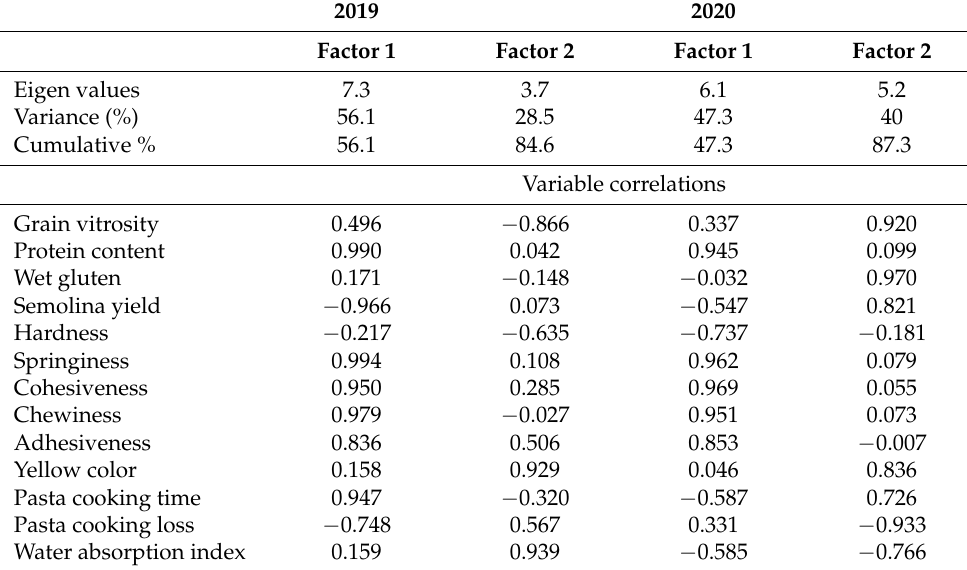
Table 5. Biplot of principal component analysis based on the correlation matrix for quality parameters of durum wheat varieties grown under CA and CT during 2018 and